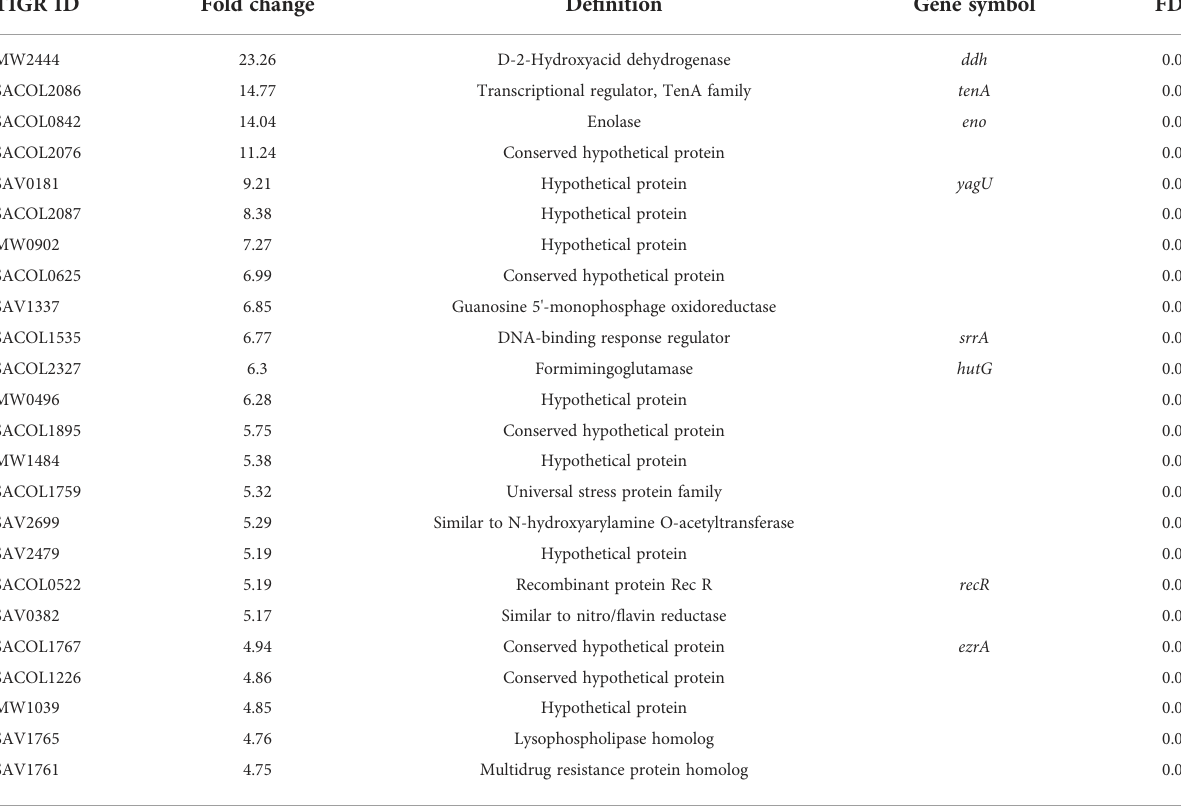
TABLE 1 Upregulated genes in gurmarin treated S. aureus bio fi lm. TIGR ID Fold